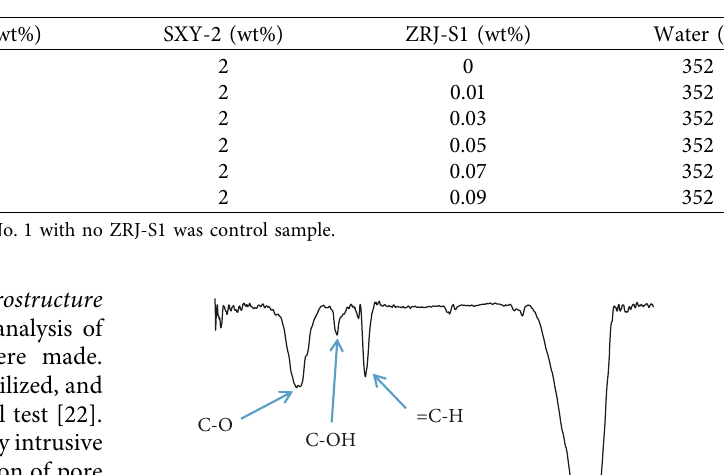
Table 3: The formulas of cement-based material.